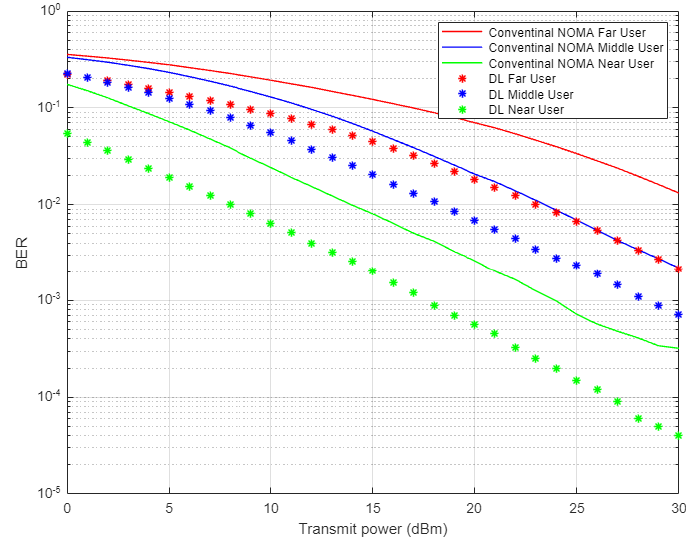
Figure 4. BER vs. power-based proposed DL-NOMA and conventional NOMA (Rayleigh Channel).